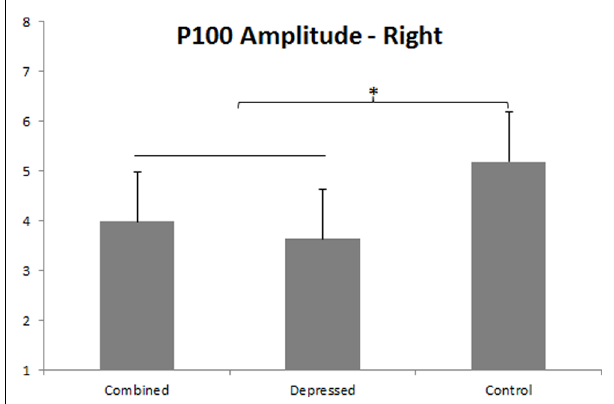
FIGURE 3 | P100 amplitude effect in right hemisphere. Error bars represent 1 SE.The asterisk indicates ( p < 0.05), that both depressed groups showed reduced P100 amplitude compared to the control group.